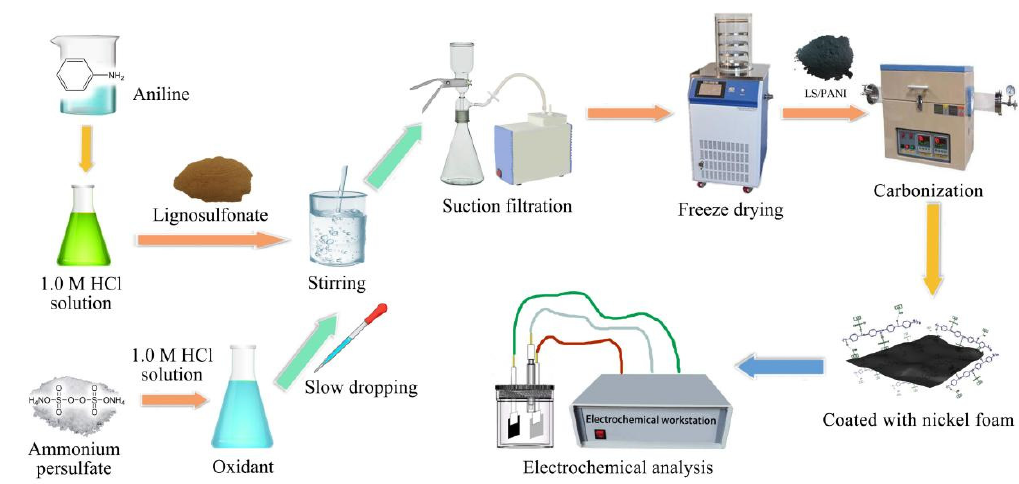
Figure 1. Flow chart of LS/PANI electrode material preparation.